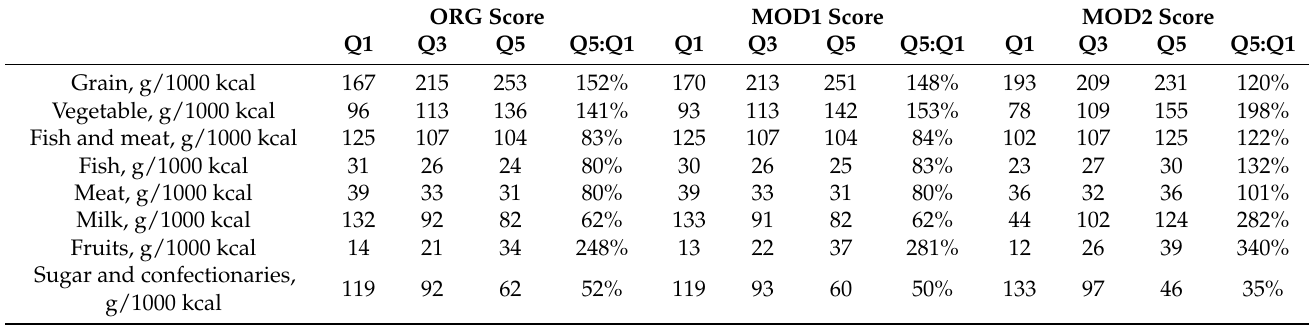
Table 3. Median intake of food groups among quintile categories of the diet quality